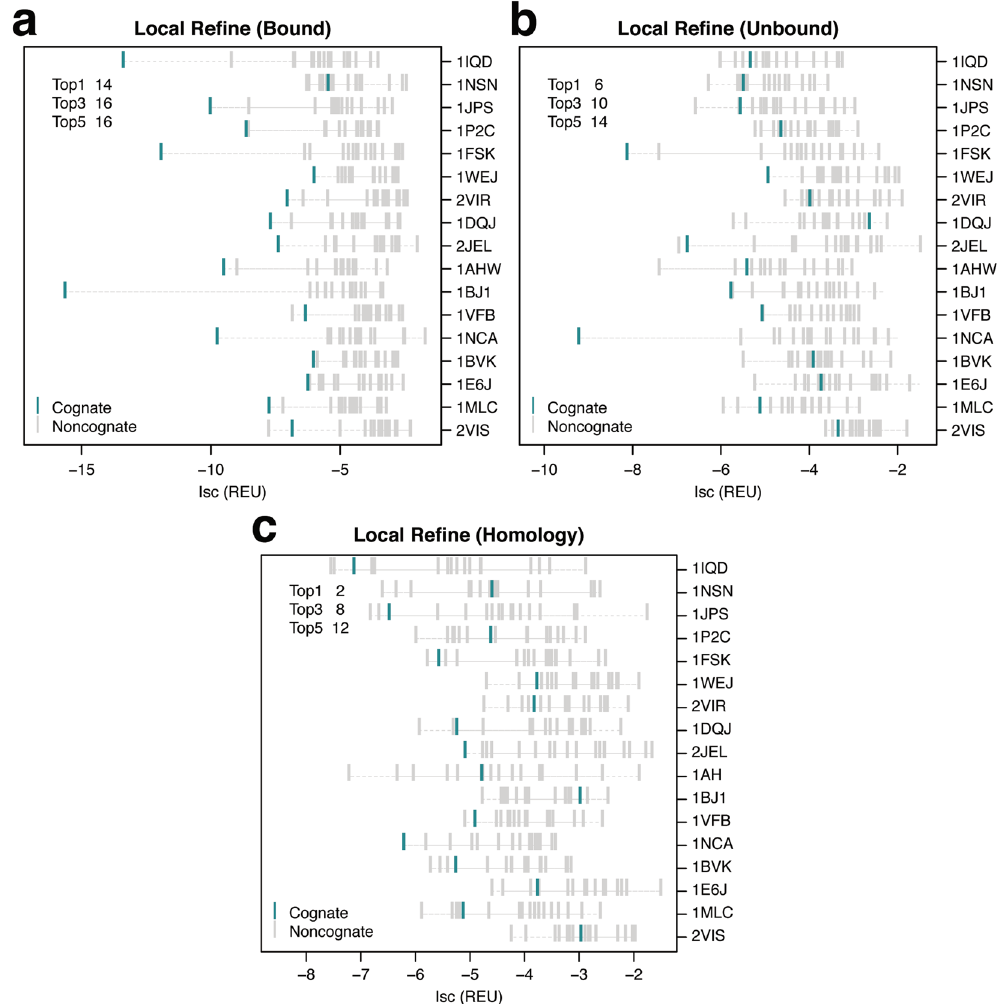
Figure 3. Ranks of cognate complexes among local refine antibody–antigen models. Interface scores (Isc) of the top-scoring cognate (turquoise) and non-cognate (grey) local refine models for ( a ) bound, ( b ) unbound, and ( c ) homology antibody–antigen complexes. Each row indicates a single antigen represented by the PDB ID of the bound complex. Antigens are sorted based on decreasing experimental binding affinities for their native antibodies (top to bottom). The top left corner shows the number of antigens where the cognate antibody complex is ranked in the top 1, 3, and 5 top-scoring cognate and non-cognate models generated for the